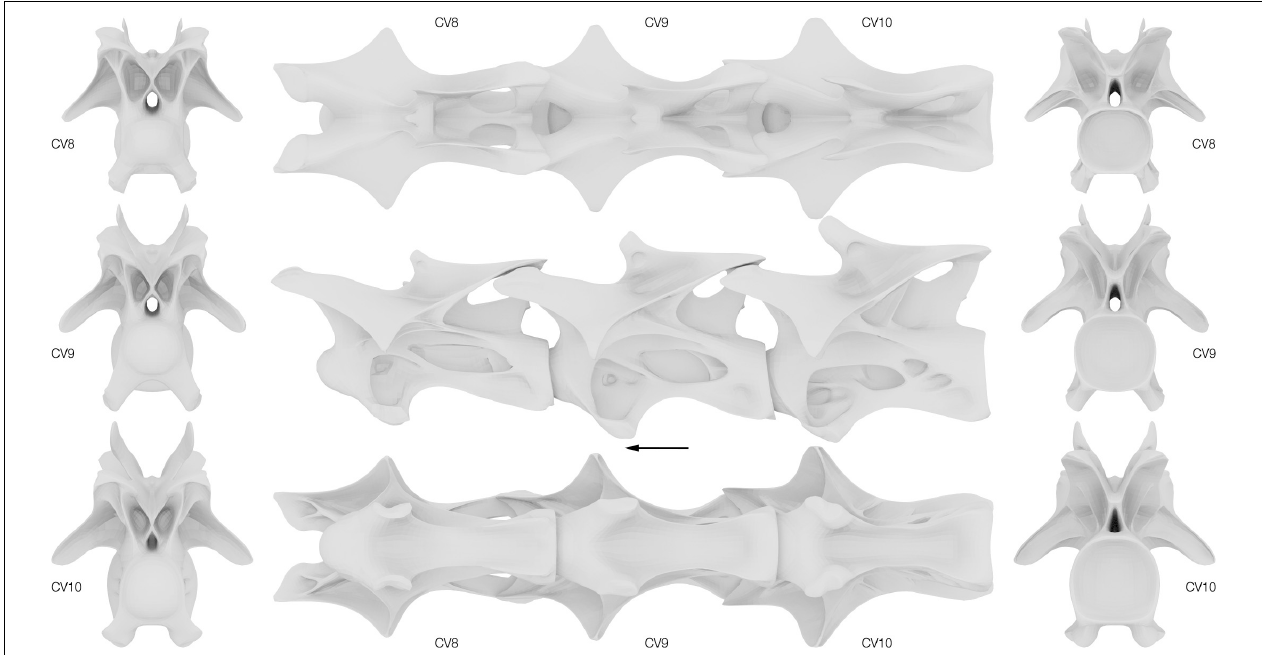
FIGURE 4 | Surface approximations of the retrodeformed Galeamopus pabsti cervical vertebrae 8–10. Left, vertebrae in cranial view; middle, vertebrae in dorsal, lateral and ventral view; right, vertebrae in caudal view. Arrow indicates cranial direction.